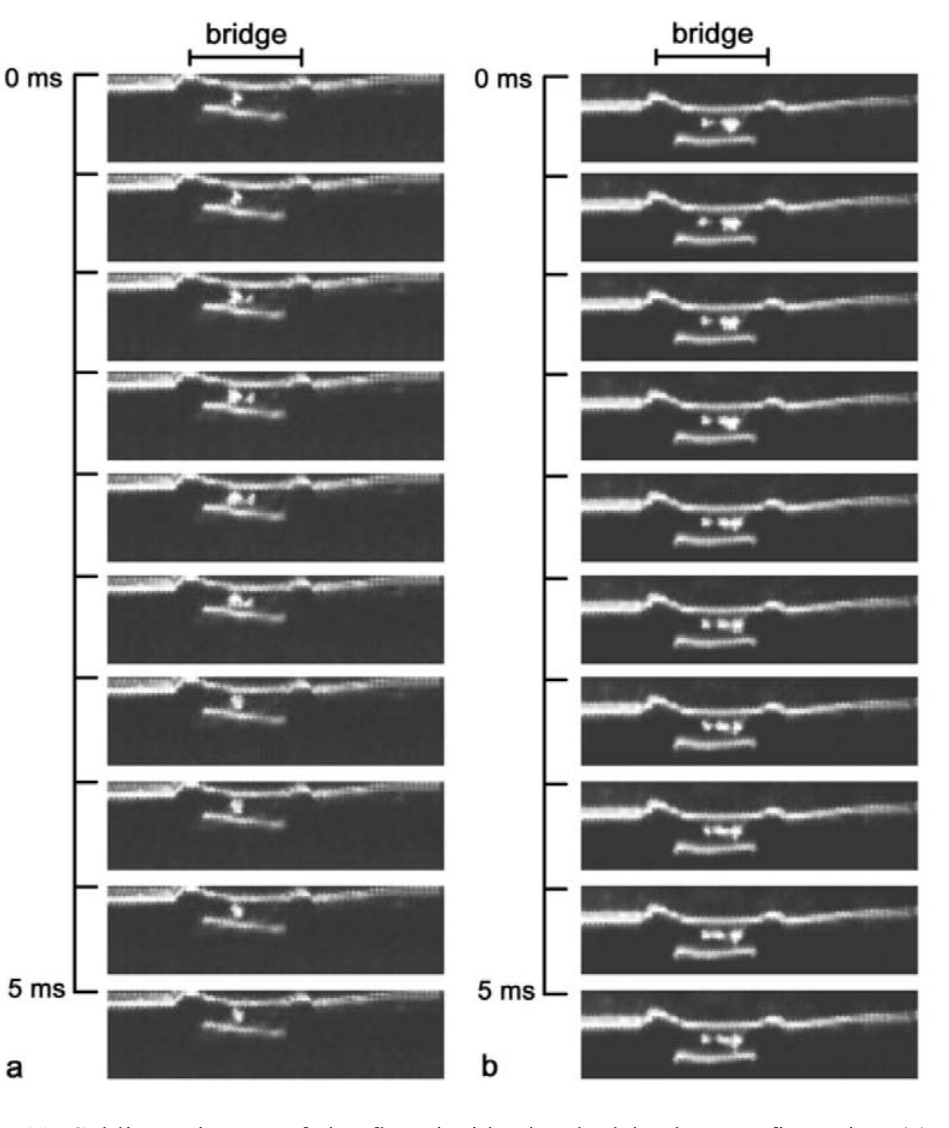
Figure 10. Density gradients within the water bridge, recorded with a high speed camera at a 10 kHz frame rate (1/20,000 s exposure time), every 5th image is depicted. (a) shows a single structure typical for a ‘young’ bridge (5 min operation time). (b) shows multiple structures (after 30 min operation time). In these images, the length of the bridge was approximately 10 mm. (from [87]).